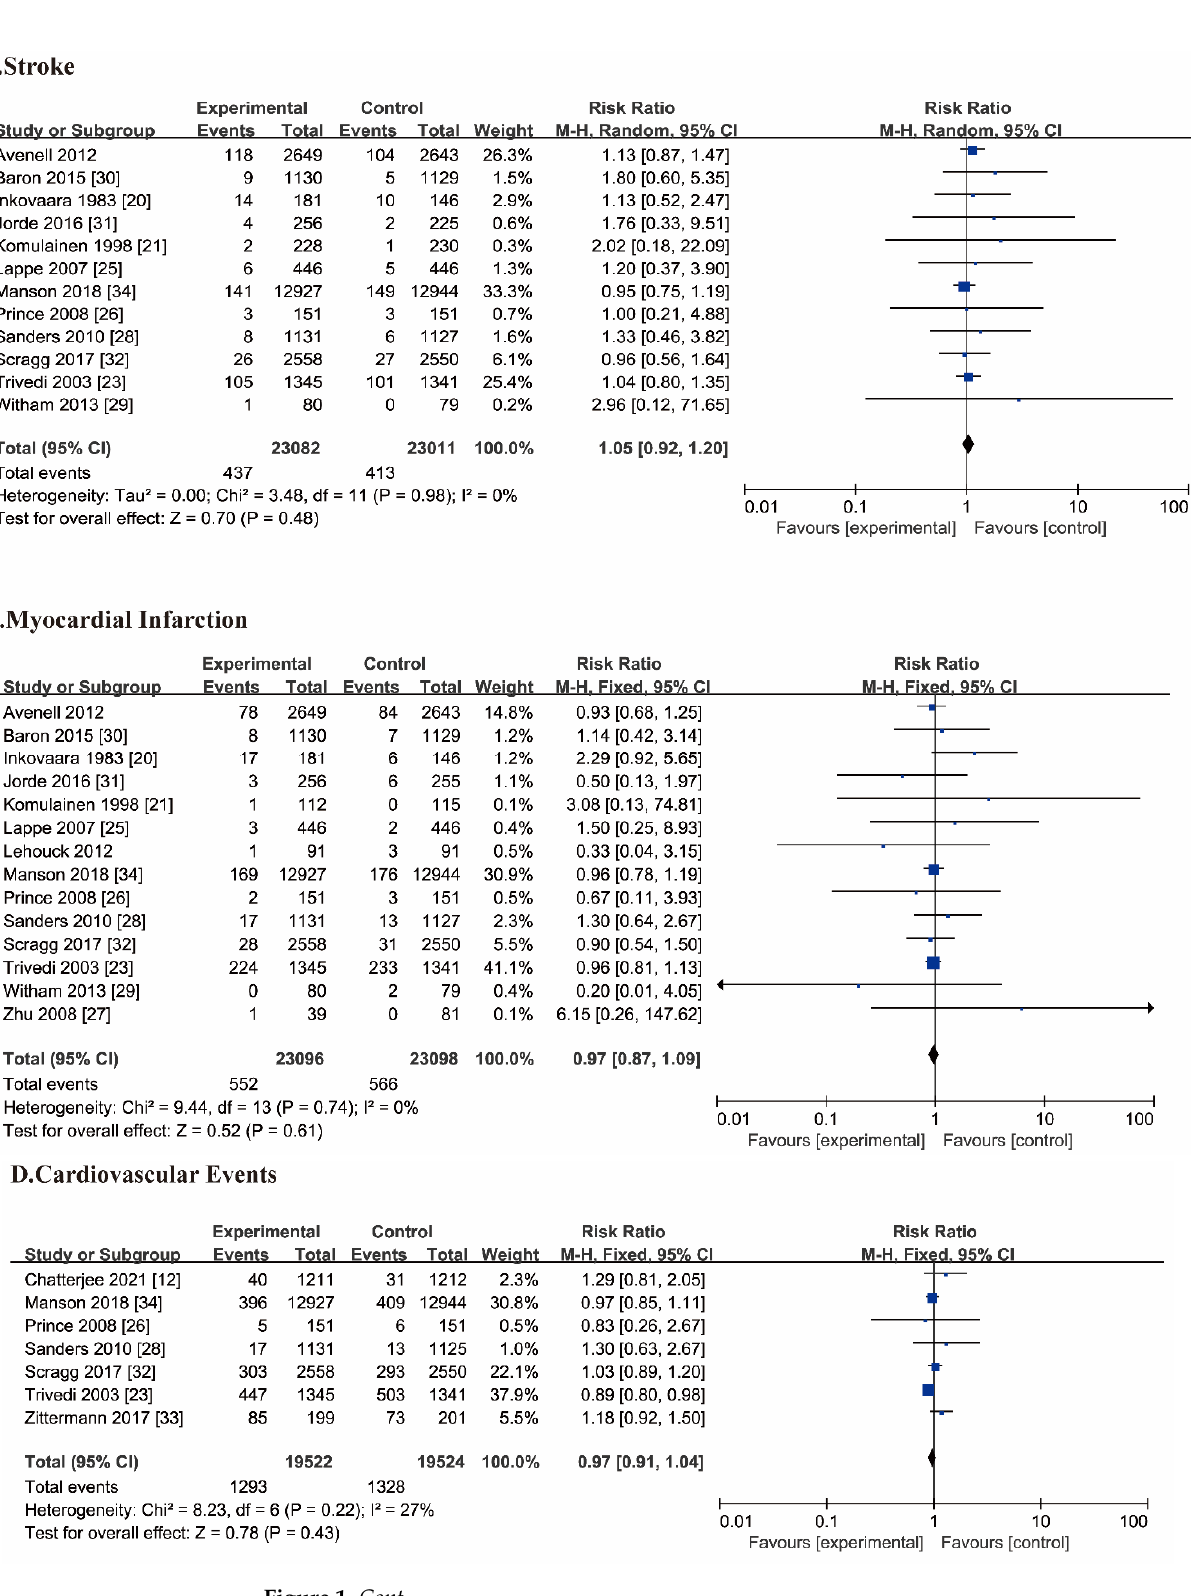
Figure 1. Forest plot comparing the effects of vitamin D on cardiovascular events . For different events, we presented in different rows in forest plots. A. cardiovascular mortality; B. stroke; C. my- ocardial infarction; D. cardiovascular events; E. cerebrovascular events . The black line represents the 95% confidence interval of each study . The blue box represents the weight of each study. The black diamond refers to results in pooled analysis. [12,13,20,21,23,25–37] 3.6. Other Analyses Prespecified subgroup analyses of all outcomes revealed no interactions between the number of patients, number of events, mean age, sex, baseline 25(OH)D, published year, type of vitamin D, daily dose equivalent of vitamin D, the timing of treatment, residential status, and length of follow-up (Table 3). The results of the sensitivity analyses were broadly consistent with the primary analysis (Supplementary Materials Table S2). Table 3. Subgroup analysis of the effect of vitamin D supplementation for CVD. Cardiovascular Mortality Stroke